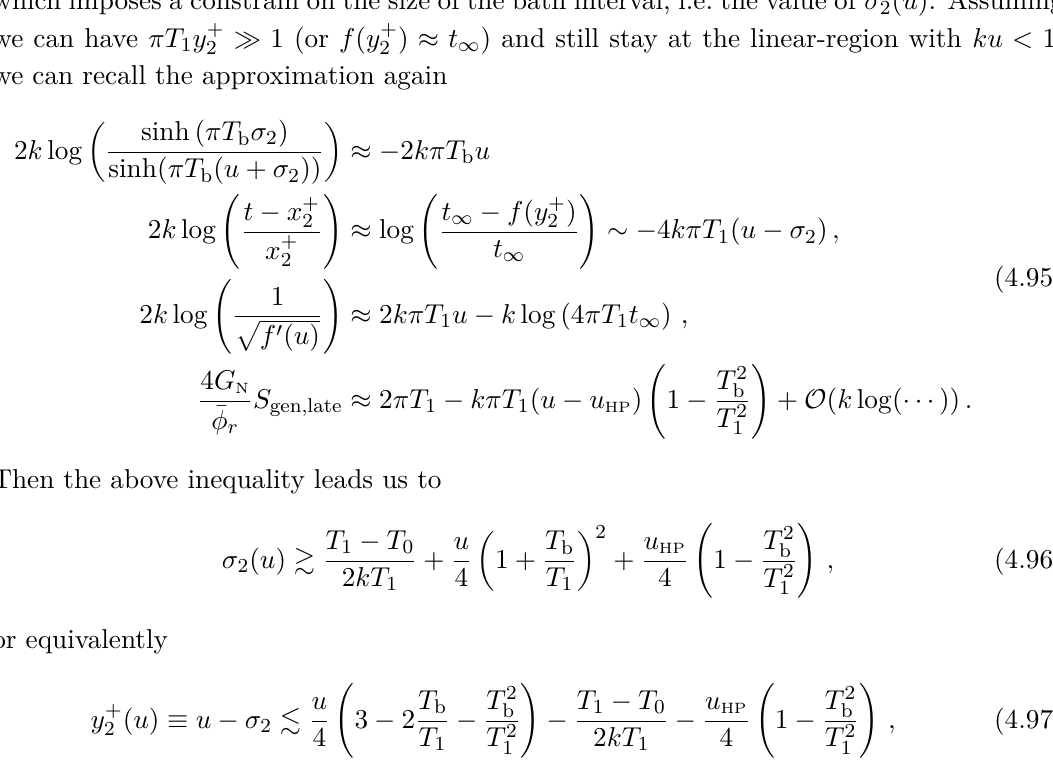
figure 4c.This analysis can be understood as an extension of the late-time protocol of [20]